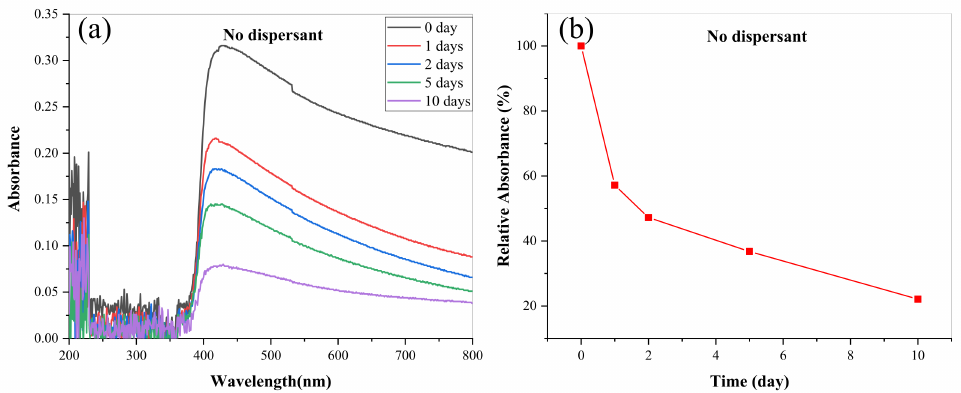
Figure 10. Evolution of absorbance of LSMLO with time. ( a ) change curves; ( b ) relative